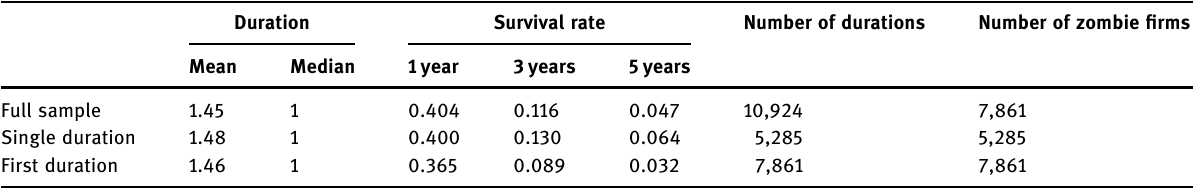
Table 10: Estimation of the duration of zombie fi rms prior to resurrection